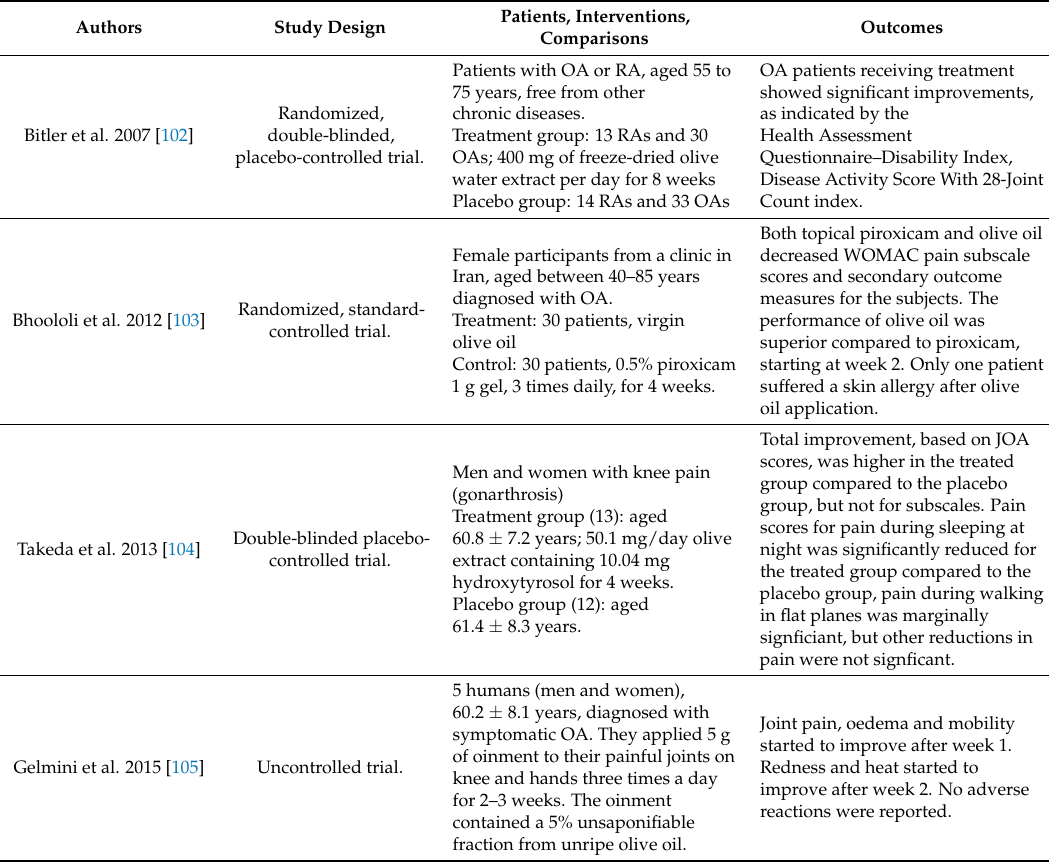
Table 1. A summary of the findings from human studies on the efficacy of olive and its derivatives against